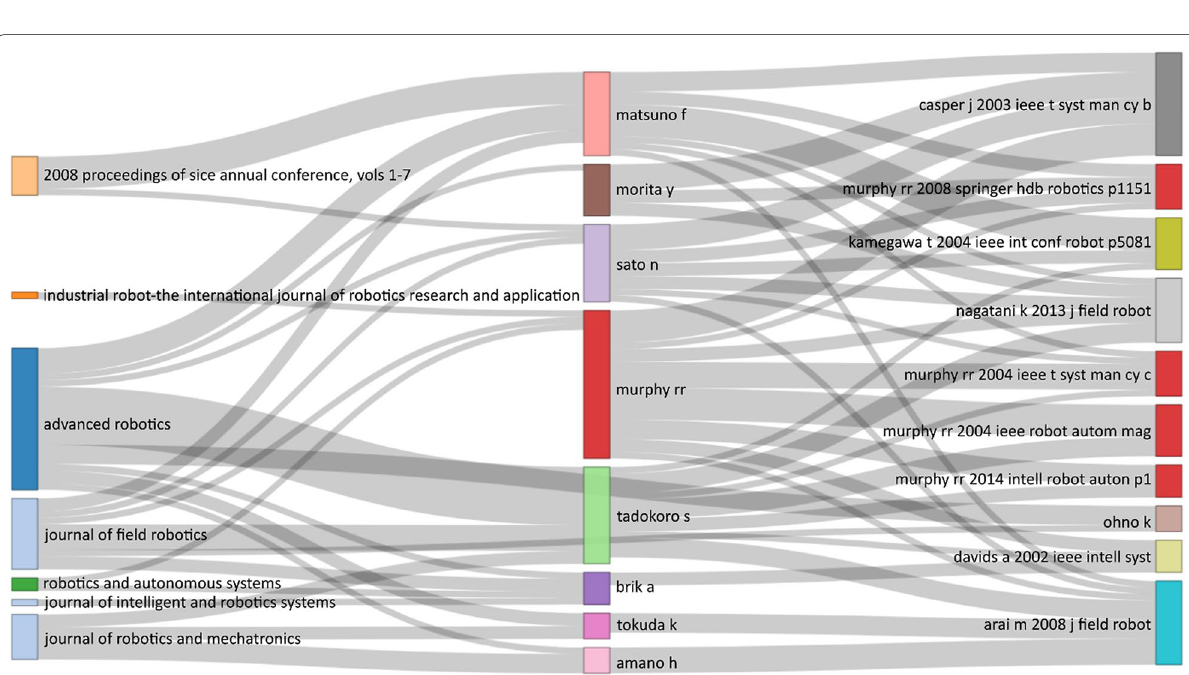
Fig. 11 Scientific correlation between prominent authors (middle), leading publications (right), and bibliometric sources (left) in